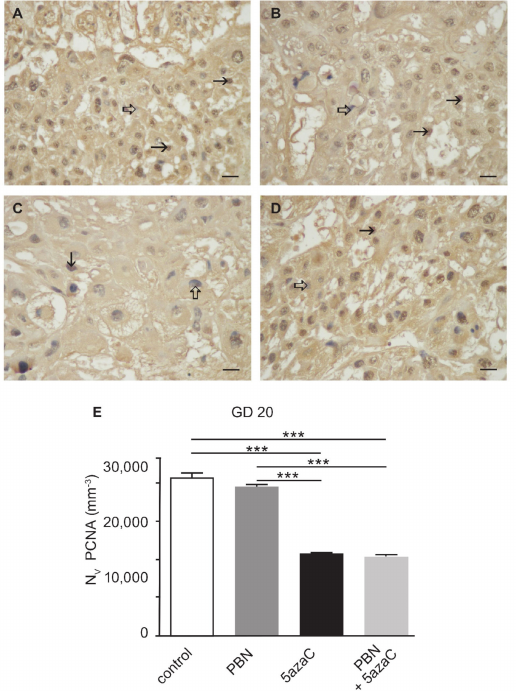
Figure 2. PCNA expression in the GD 20 rat placenta treated with PBN and/or 5-azaC on days GD 12–13. ( A ) control, ( B ) PBN, ( C ) 5azaC, ( D ) PBN + 5azaC. Arrow–PCNA-positive cell, thick arrow–internal negative control. DAB, haematoxylin counterstain. Scale bar 25 µ m. ( E ) Stereological